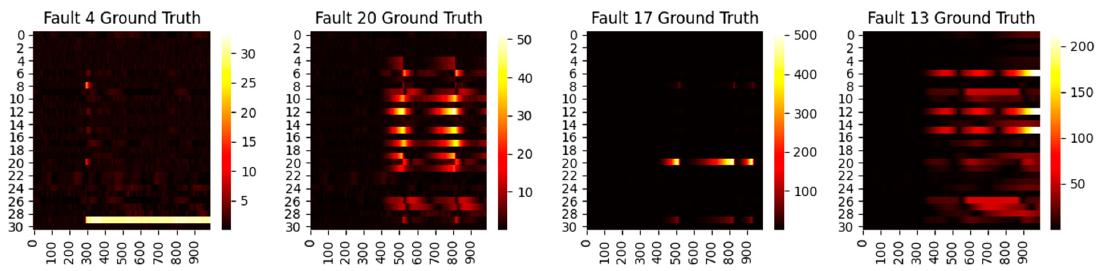
Figure 5. Ground truth heat maps of faults 4, 20, 17, and 13. The horizontal axis denotes the sampling time, while the vertical axis indicates the variable number.